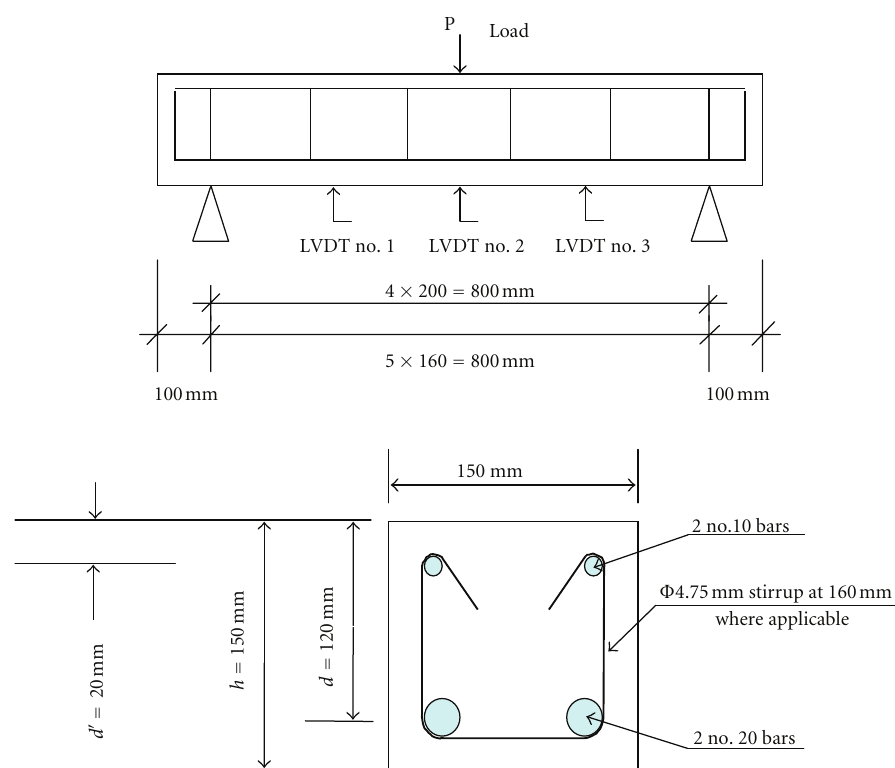
Figure 1: Load configuration and cross-sectional details of RC beams.